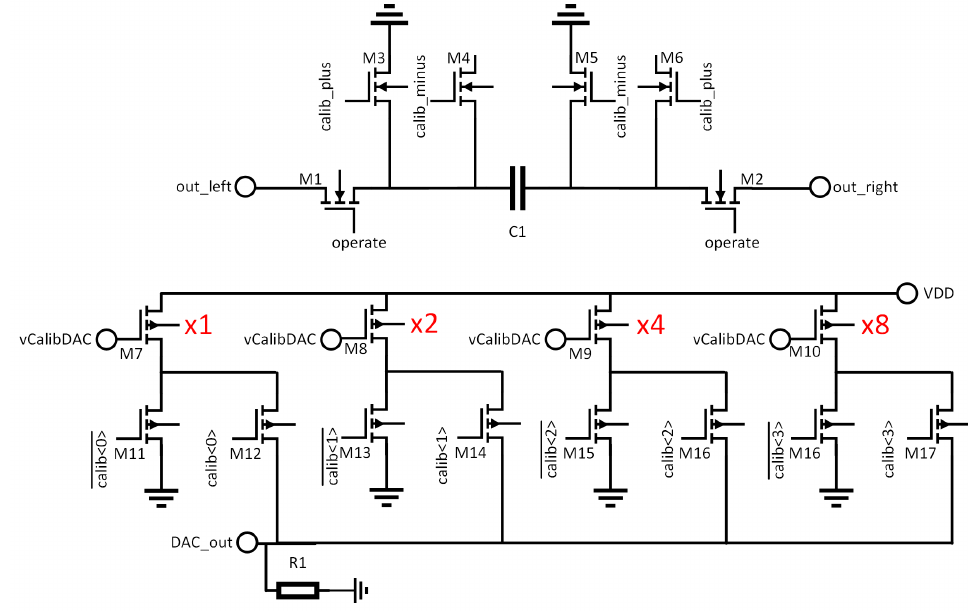
Figure 7. Detailed schematic of the trim DAC and capacitor. For clarity, substrate connections are not shown. All NMOS have their substrates connected to ground, all PMOS to VDD. Relative sizes of the DAC branches are illustrated in